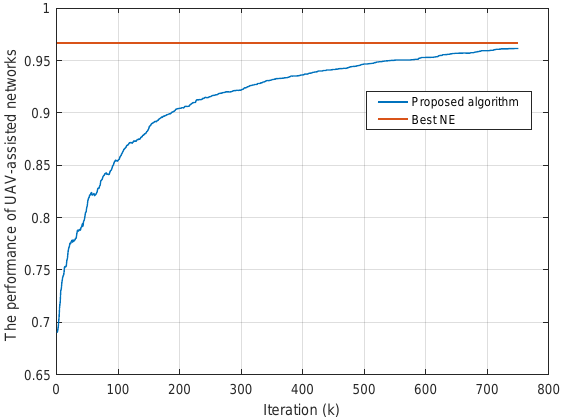
Figure 2. The convergence of the proposed algorithm ( | f | = 6, N = 8 and | c n | = 3).